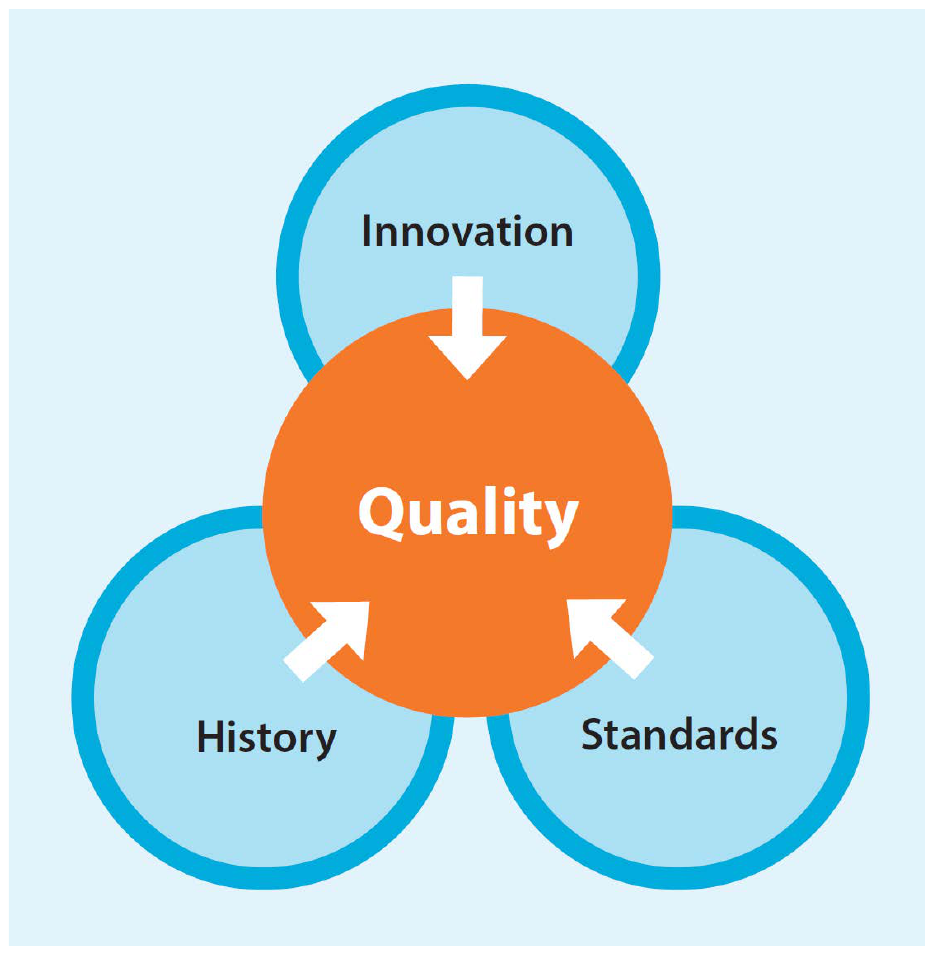
Figure 2 . The three sources for learning